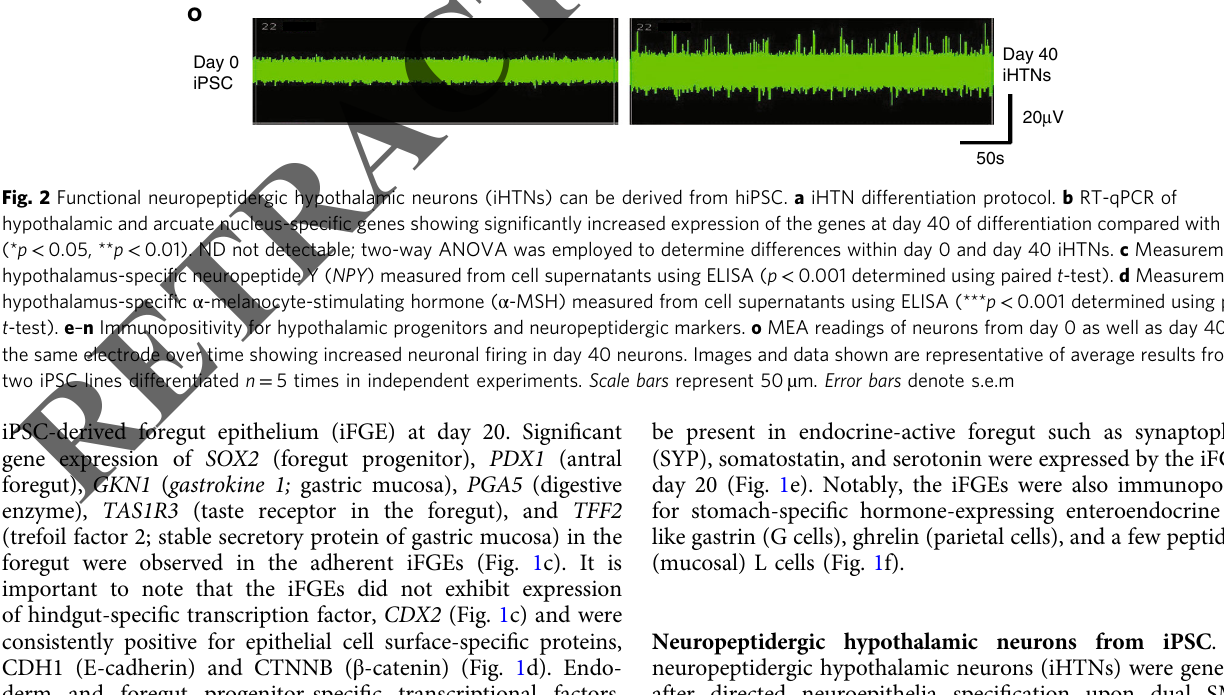
the same electrode over time showing increased neuronal fi ring in day 40 neurons. Images and data shown are representative of average results from the two iPSC lines differentiated n = 5 times in independent experiments. Scale bars represent 50 µ m. Error bars denote be present in endocrine-active foregut such as synaptophysin iPSC-derived foregut epithelium (iFGE) at day 20. Signi fi cant (SYP), somatostatin, and serotonin were expressed by the iFGE at gene expression of SOX2 (foregut progenitor), PDX1 (antral day 20 (Fig. 1e). Notably, the iFGEs were also immunopositive foregut), GKN1 ( gastrokine 1; gastric mucosa), PGA5 (digestive for stomach-speci fi c hormone-expressing enteroendocrine cells enzyme), TAS1R3 (taste receptor in the foregut), and TFF2 like gastrin (G cells), ghrelin (parietal cells), and a few peptide YY (trefoil factor 2; stable secretory protein of gastric mucosa) in the foregut were observed in the adherent iFGEs (Fig. 1c). It is important to note that the iFGEs did not exhibit expression of hindgut-speci fi c transcription factor, CDX2 (Fig. 1c) and were consistently positive for epithelial cell surface-speci fi c proteins, CDH1 (E-cadherin) and CTNNB ( β -catenin) (Fig. 1d). Endo- derm and foregut progenitor-speci fi c transcriptional factors, Sox17 and Sox2, respectively, con fi rm the foregut identity of the iFGEs (Fig. 1d). Importantly, neuroendocrine markers known to